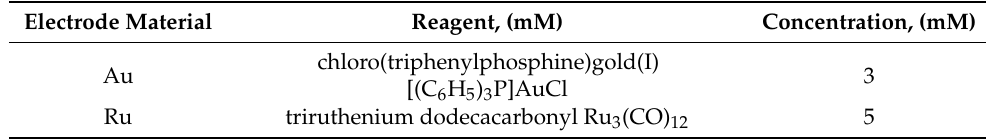
Table 1. The composition of solutions used for laser-assisted deposition of Au and Ru structures. In both cases, DMF ( N , N -dimethylformamide) was used as a